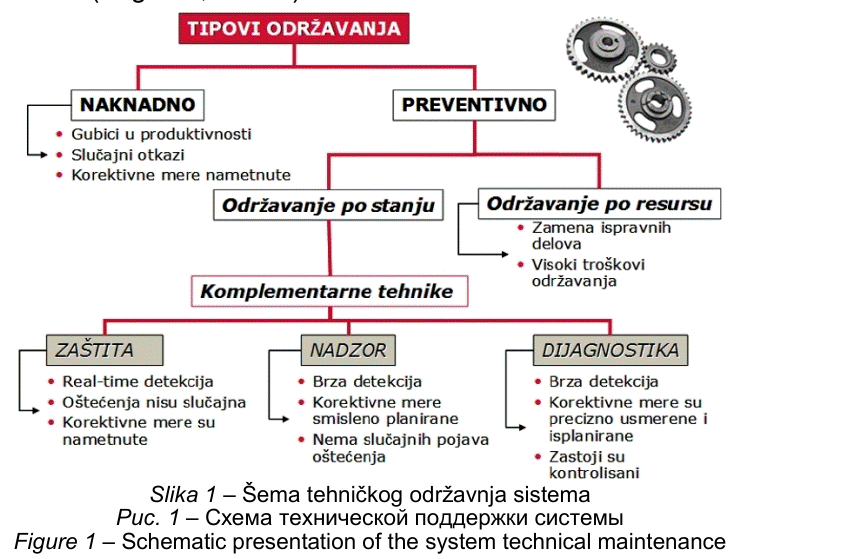
Figure 1 – Schematic presentation of the system technical